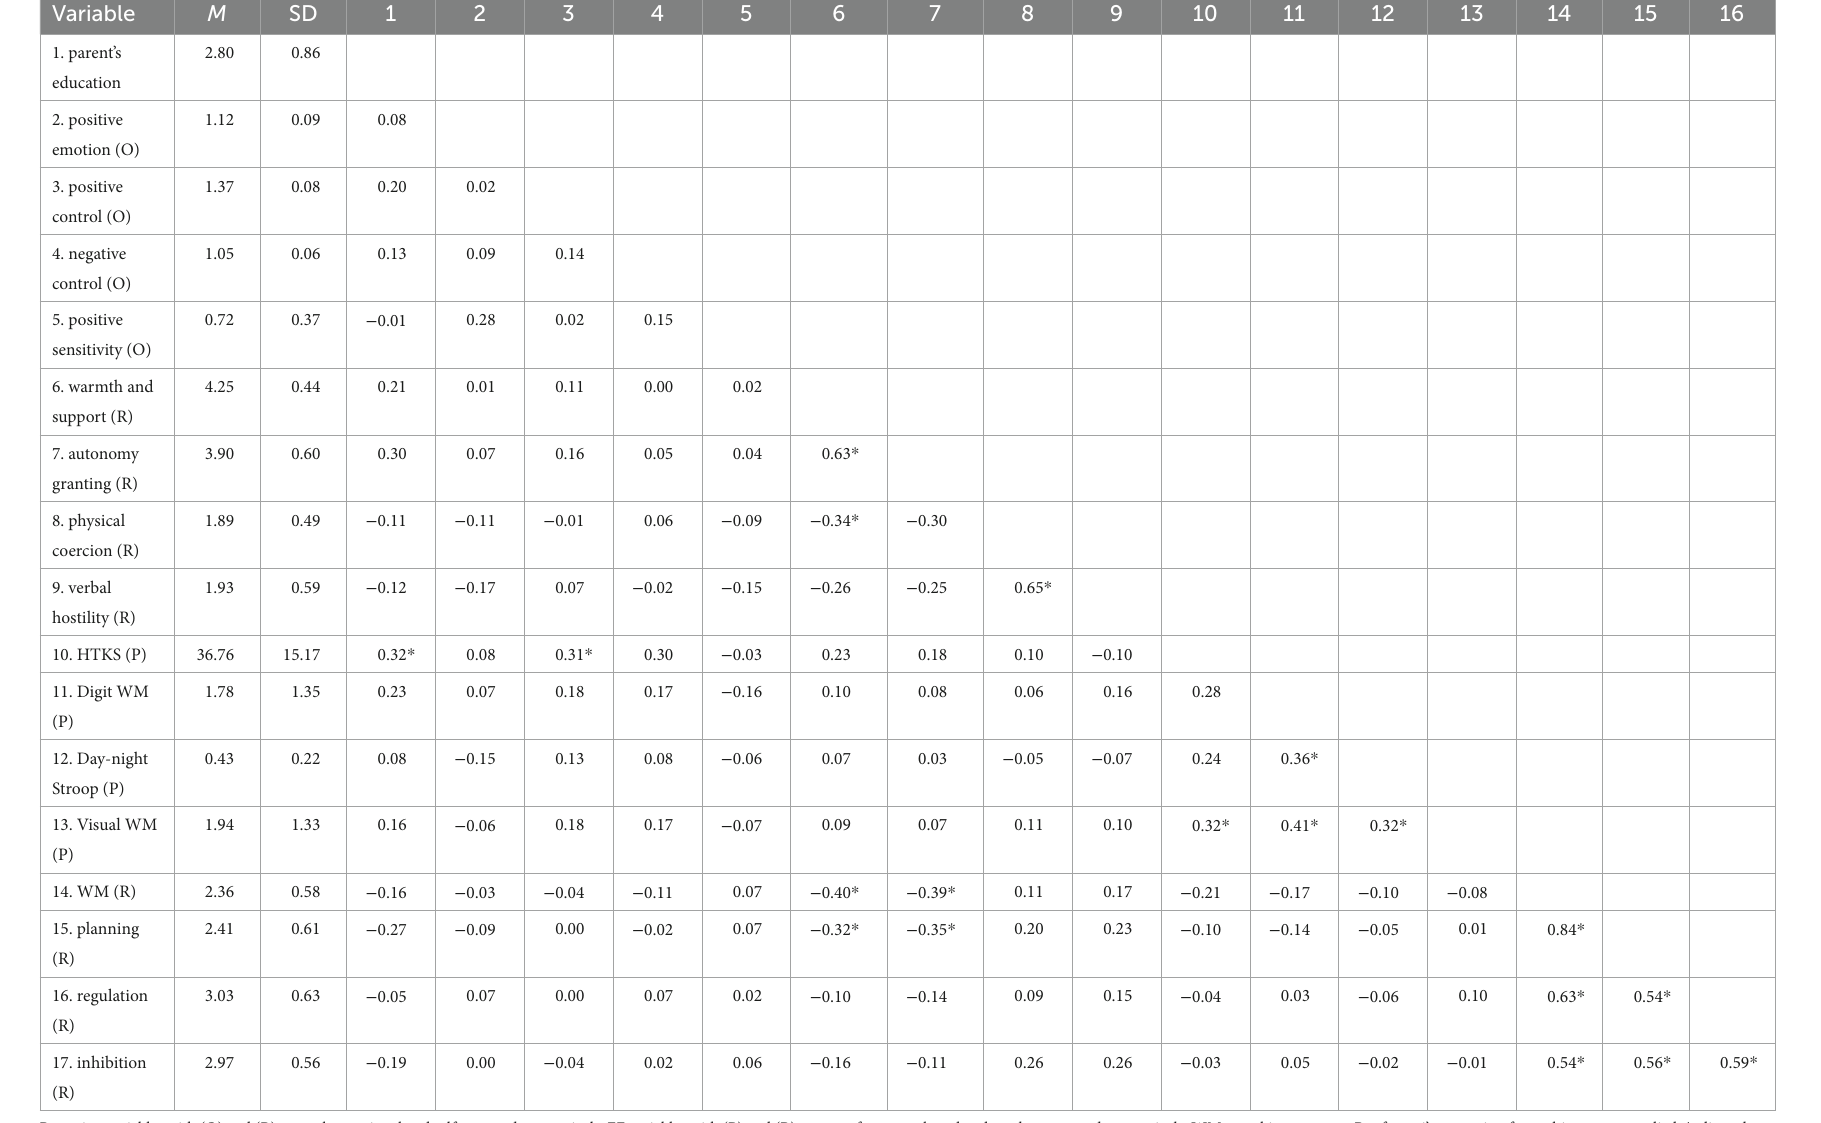
TABLE 1 Means and standard deviations of the variables used in this study and their correlations.